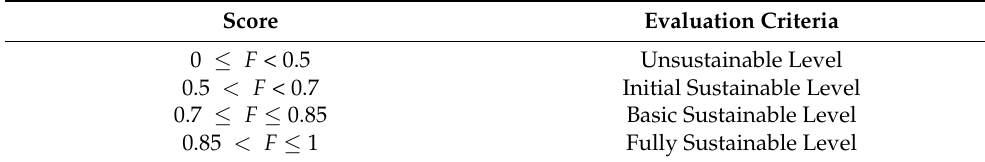
Table 3. Evaluation criteria for SLU